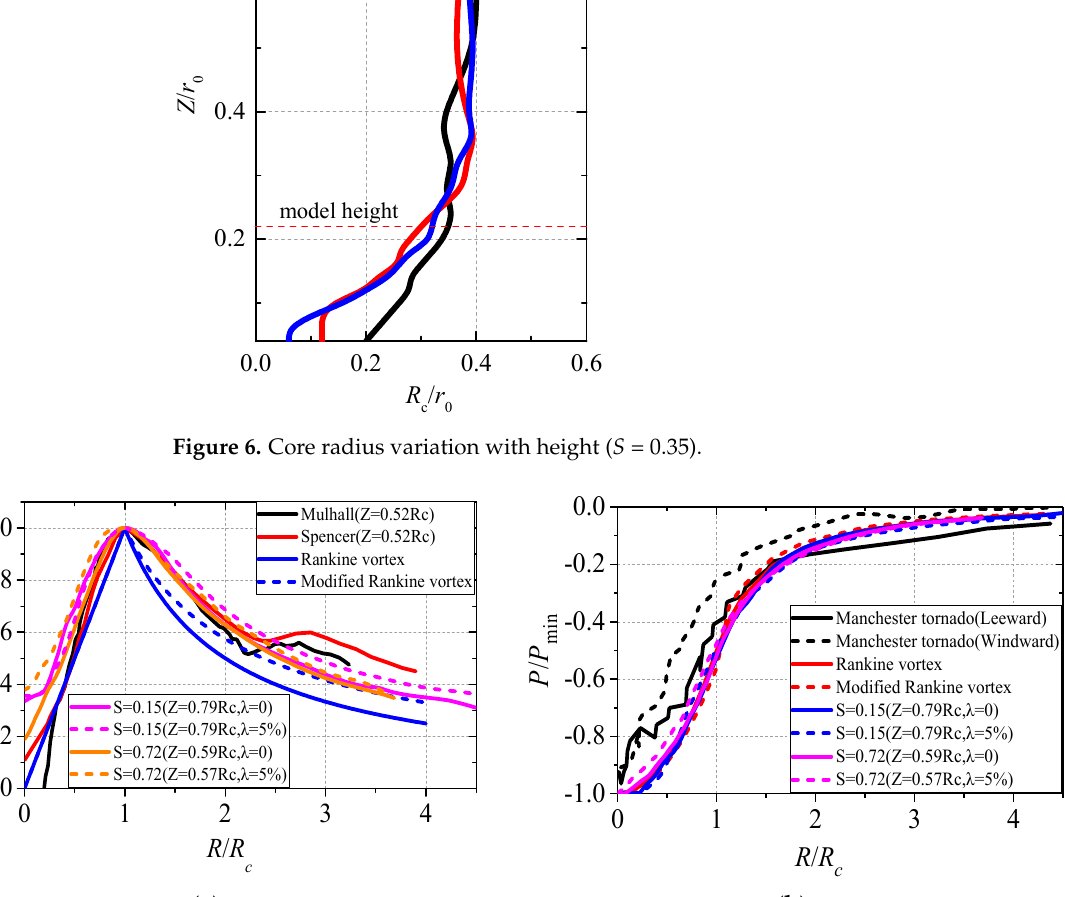
Figure 7. Comparison of normalized radial profiles of tangential velocity ( a ) and pressure drop ( b ) between experimental results, results from empirical models, and data measured from an actual tornado.